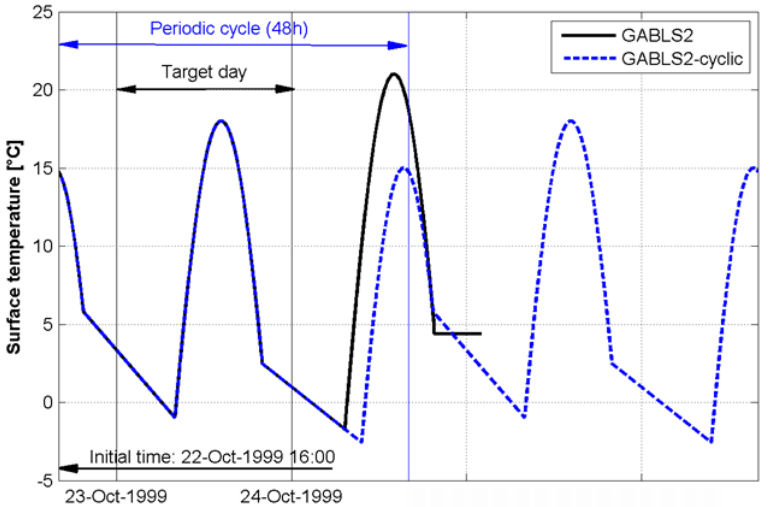
Figure 4. GABLS2 surface temperature profile (Svensson et al., 2011) and alternative 48h periodic cycle used to obtain a diurnal cycle independent of initial conditions.